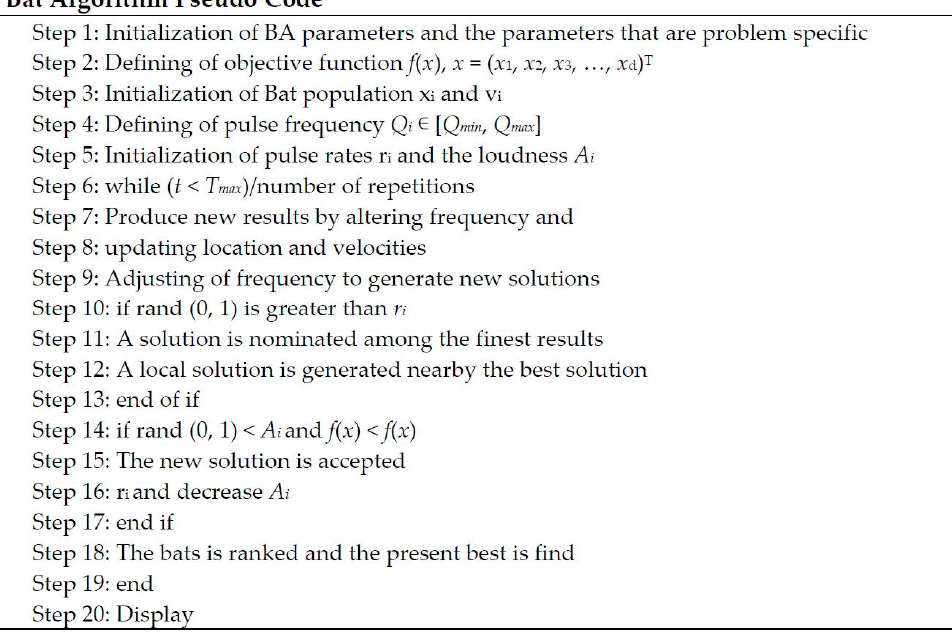
Figure 2. Pseudo code of bat algorithm (BA).